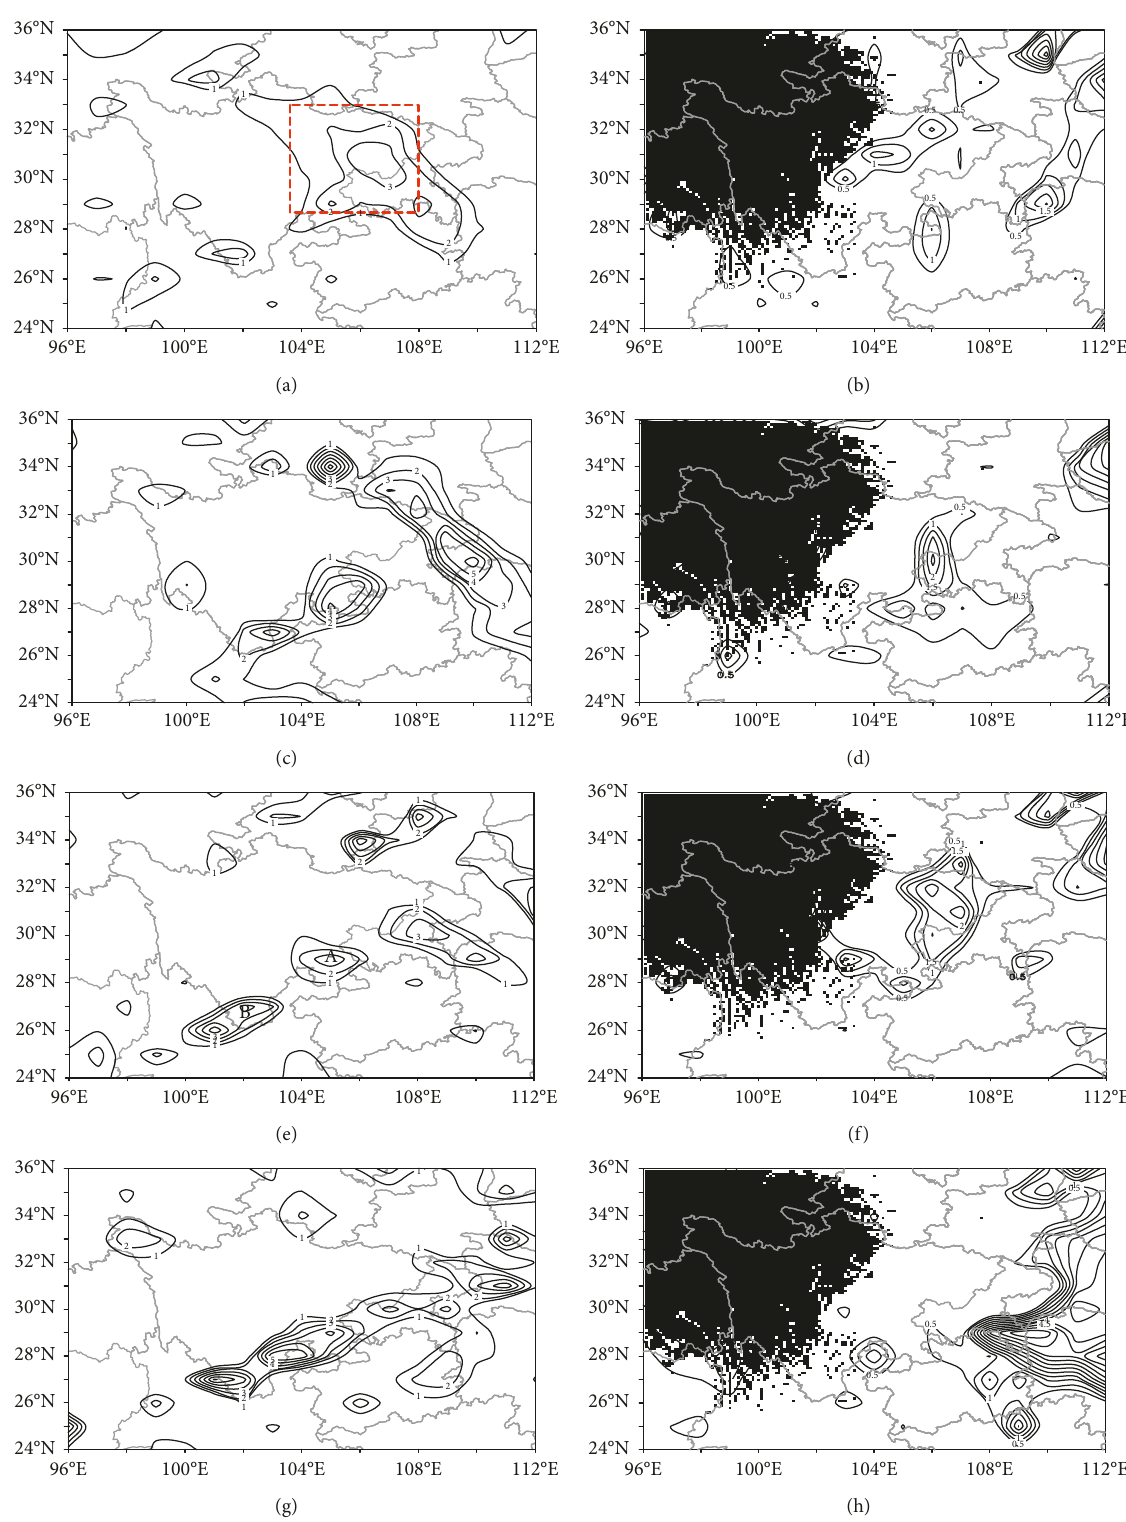
Figure 11: 500hPa vorticity advection (a, c, e, g) (10 − 9 s − 2 ) and 850hPa PEPTadvection (b, d, f, h) (10 − 4 K · s − 1 ) at (a, b) 0000 UTC 27 October 2014, (c, d) 0600 UTC 27 October 2014, (e, f) 1200 UTC 27 October 2014, and (g, h) 0000 UTC 28 October 2014. In (e), A—Luzhou;